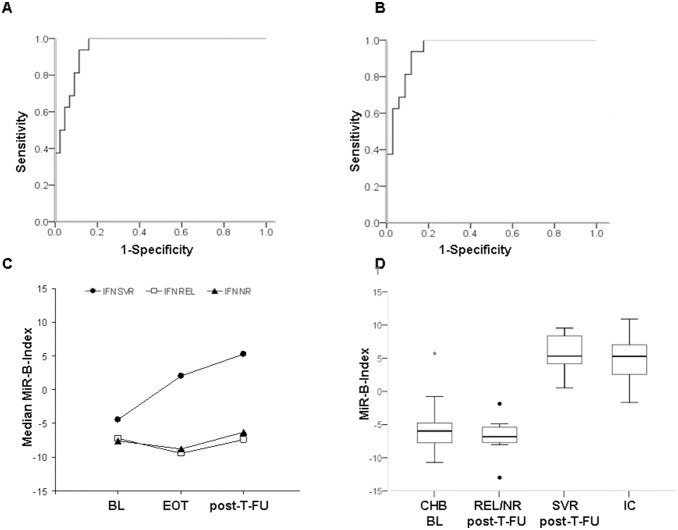
MiR-B-Index in HBV carriers: diagnostic performance to identify inactive carriers (AUROCs), index kinetics in Peg-IFN treated patients by outcome and distribution of the index values by treatment outcome and phase of HBV infection.
A) Receiver operating characteristic curve for MiR-B-Index in IC vs patients with chronic hepatitis (HBeAg positive or negative CHB, HBV/HDV chronic hepatitis, ALD1): 0.9520 (95% CI 0.903 to 1.000, p<0.001); B) ROC for MiR-B-Index in IC vs HBeAg negative CHB (ALD2): 0.954 (95% CI 0.902 to 1.000, p<0.001; C) Kinetics of MiR-B-Index in 14 patients treated with Peg-IFN: MiR-B-Index values progressively increased in SVR, whereas they showed minor fluctuations in REL/NR (p<0.001); D) Whisker plot of the MiR-B-Index (y-axis) values in BL CHB patients treated with Peg-IFN (NR, REL and SVR), 24 week post-T-FU of REL/NR and SVR and IC, separately (CHB-BL vs IC p<0.001; SVR-BL vs SVR PT-FU p<0.001; REL/NR BL vs REL/NR PT-FU p = 0.462; SVR PT-FU vs IC p = 0.792).